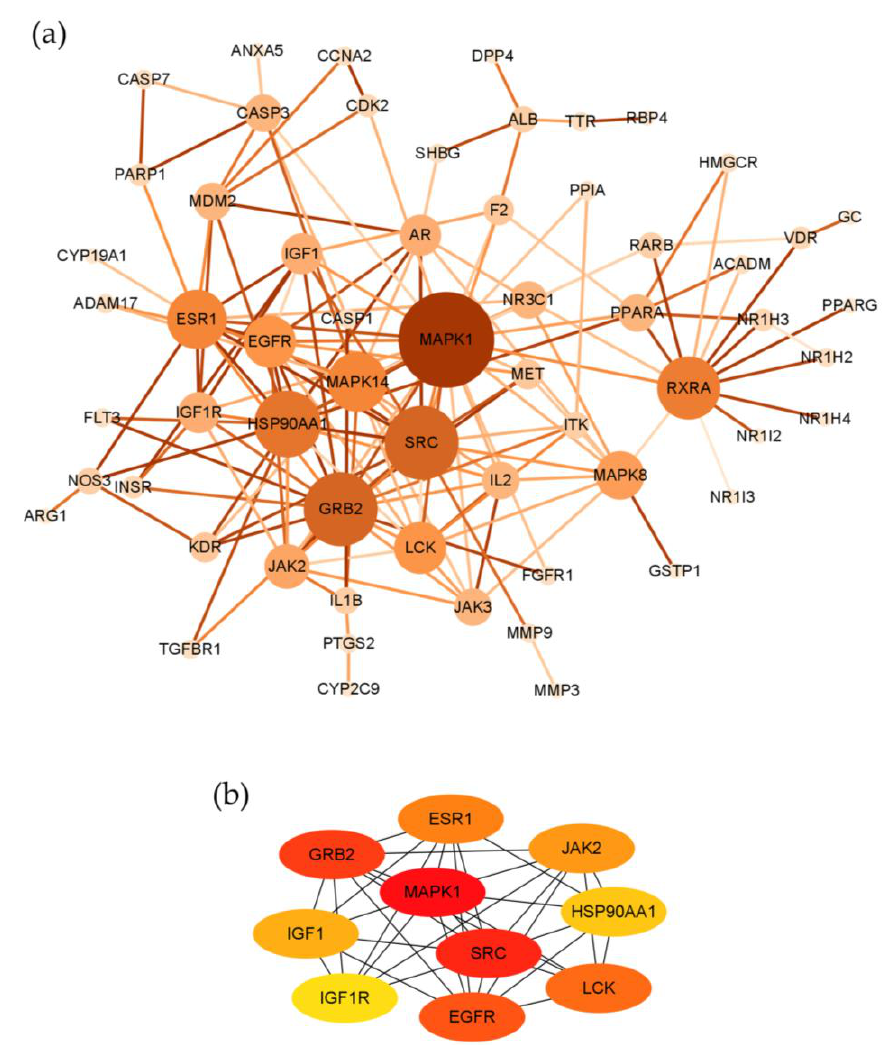
Figure 5. Protein–protein interaction network analysis. ( a ) Protein–protein interaction network of intersecting targets of costunolide and AIH visualized by Cytoscape. ( b ) The core subnetwork constructed by CytoHubba.